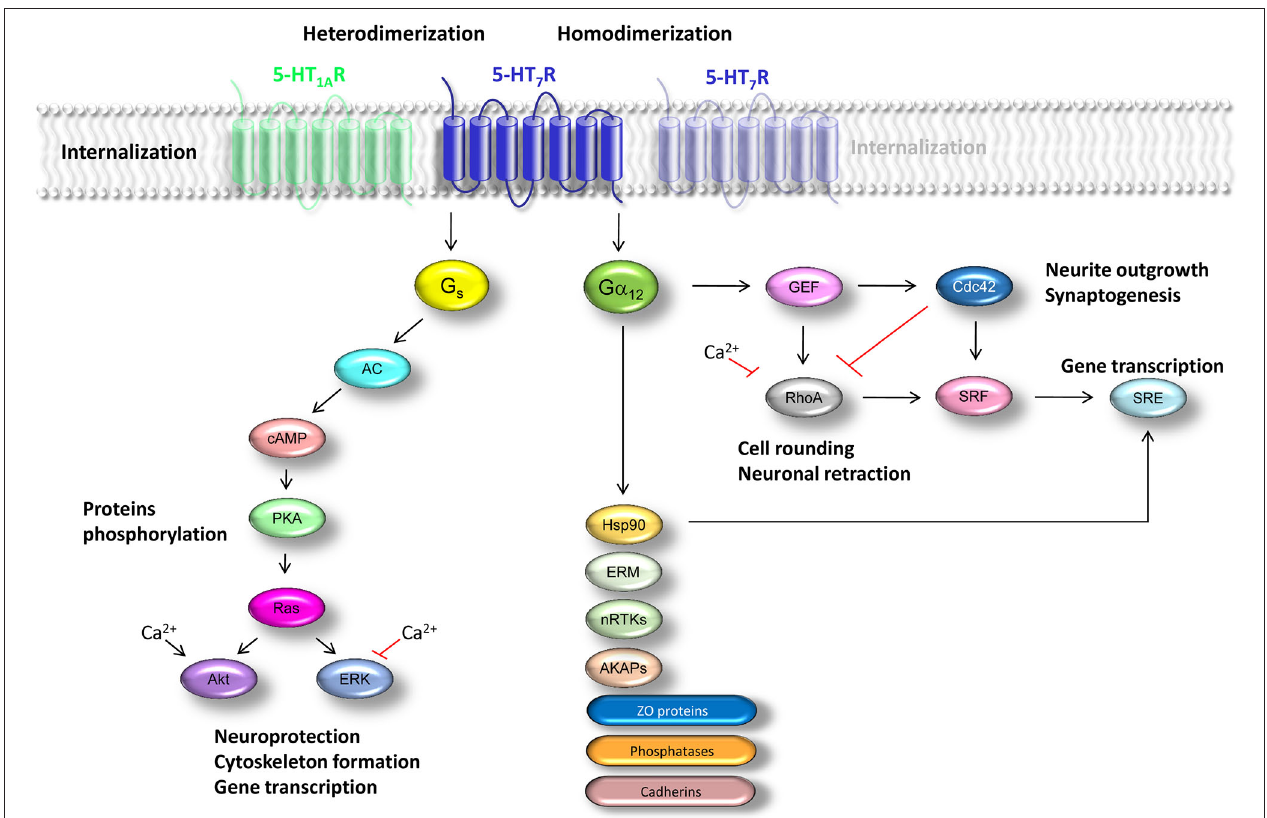
FIGURE 1 | Schematic representation of signaling pathways regulated by the 5-HT 7 receptor . Effects mediated by G s -proteins are in the left section. Summary of the G 12 -mediated signaling processes is shown in the right section. Abbreviations: GIRK—G-protein coupled inward rectifier potassium channel; AC—adenylyl cyclase; cAMP—cyclic adenosine monophosphate; PKA—protein kinase A; ERK—extracellular signal-regulated